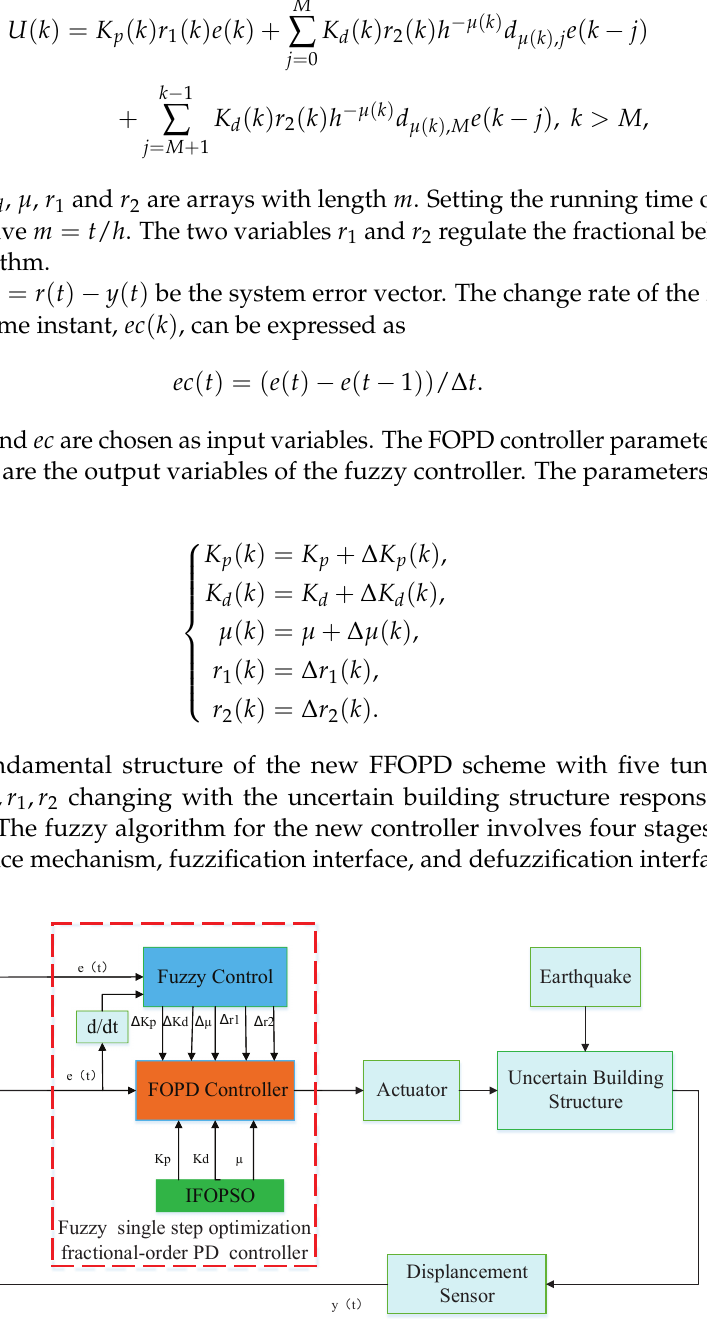
Figure 7. Control system using the FFOPD under uncertain building